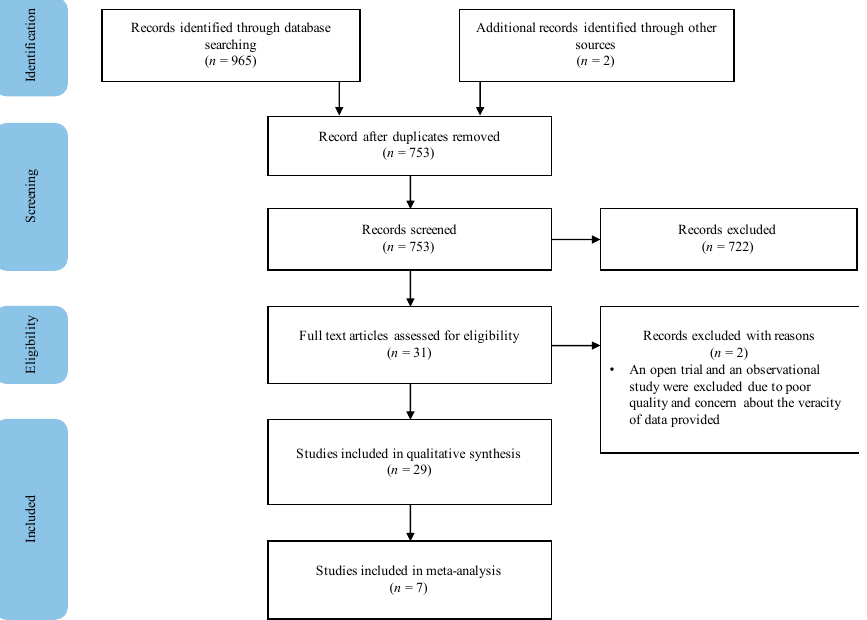
Figure 1. Study selection procedure.